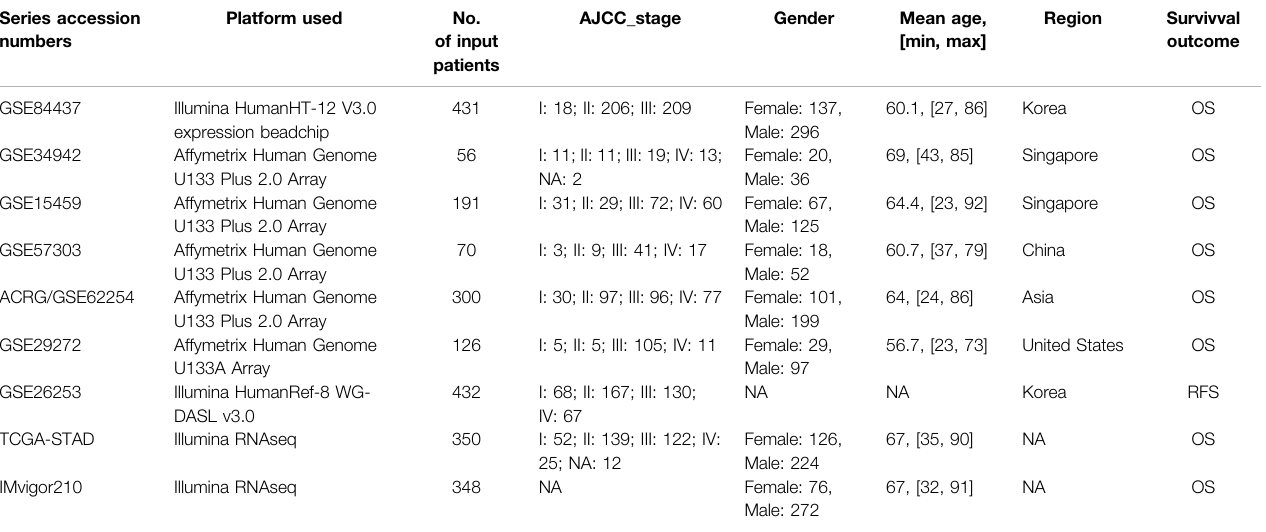
TABLE 1 | Basic information of series used in this